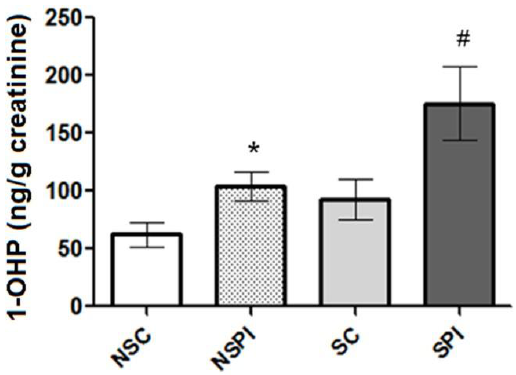
Figure 2. Urinary 1-hydroxypyrene (1-OHP) levels observed in the groups of study. Results are expressed as mean ± SE (standard error). NSC (non-smoker controls); NSPI (non-smoker post-infarction subjects); SC (smoker controls); SPI (smoker post-infarction subjects). * p < 0.01 for non-smokers (post-infarction compared to control). # p < 0.01